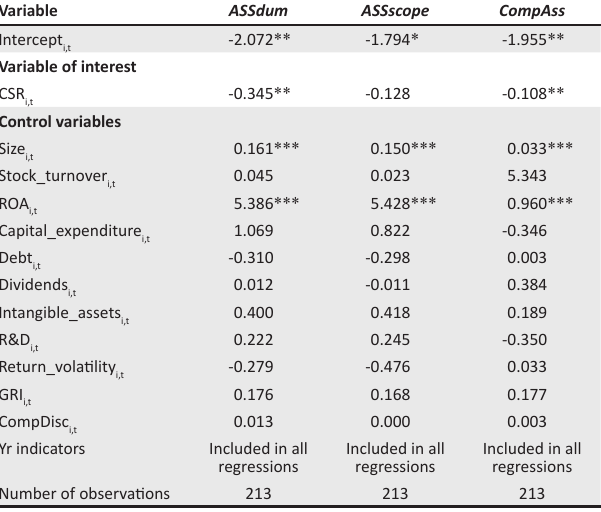
TABLE 4: Regression results for firm value – corporate social responsibility assurance measures controlling for disclosure. Variable ASSdum ASSscope